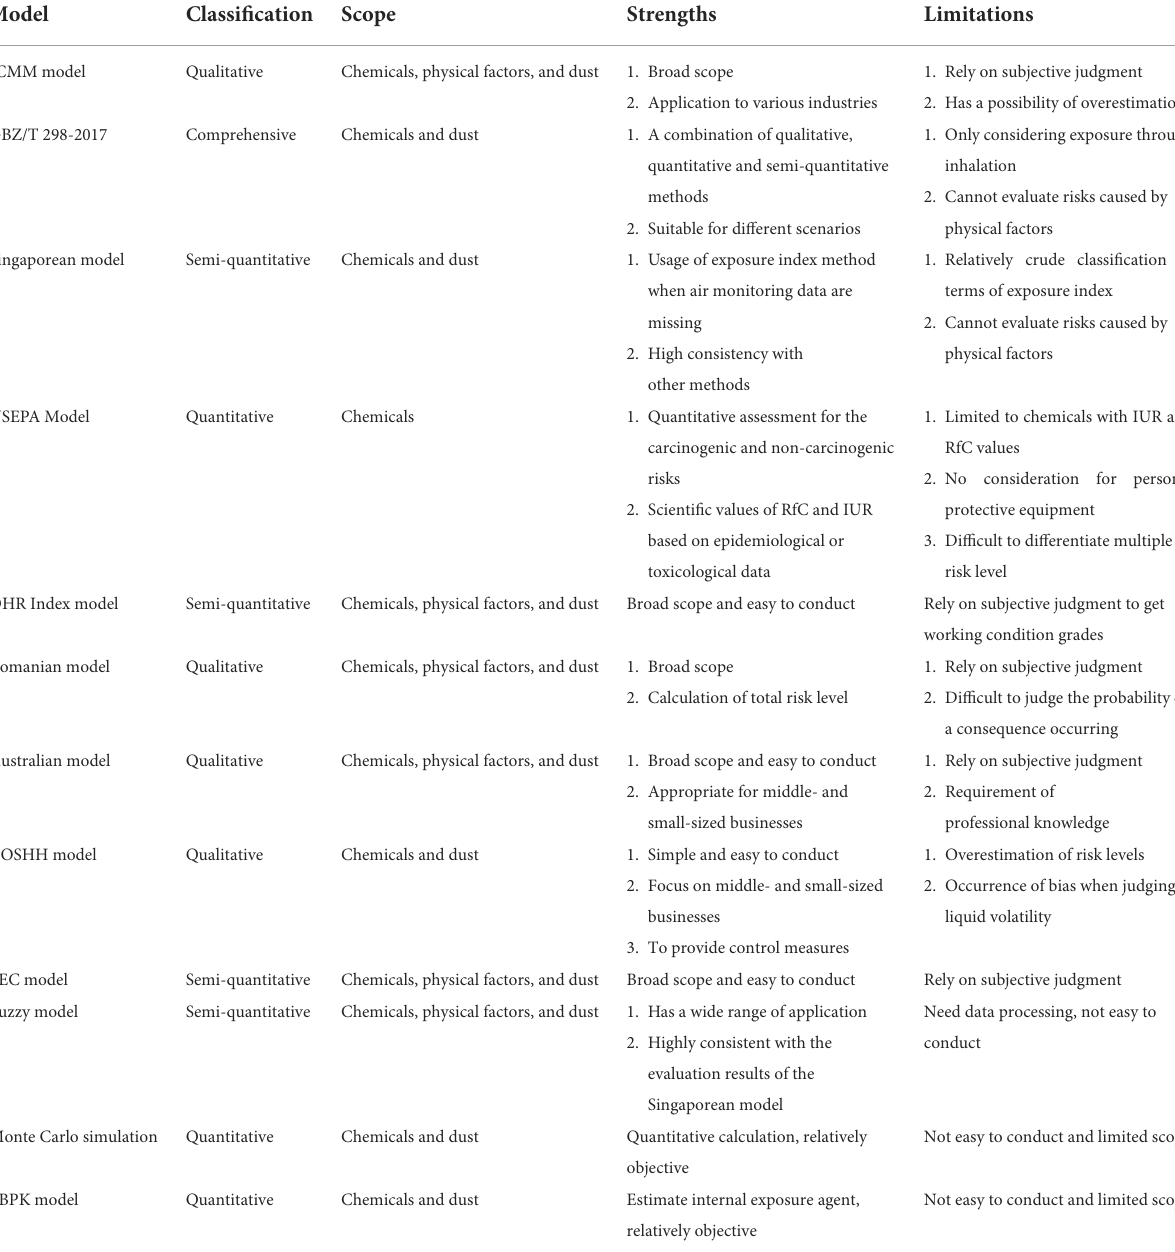
TABLE 2 Qualitative comparisons between OHRA